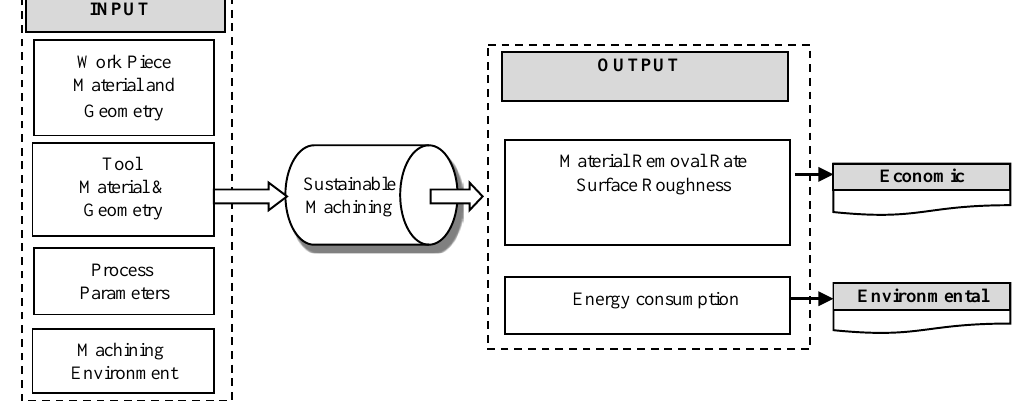
Fig. 3. System boundary for